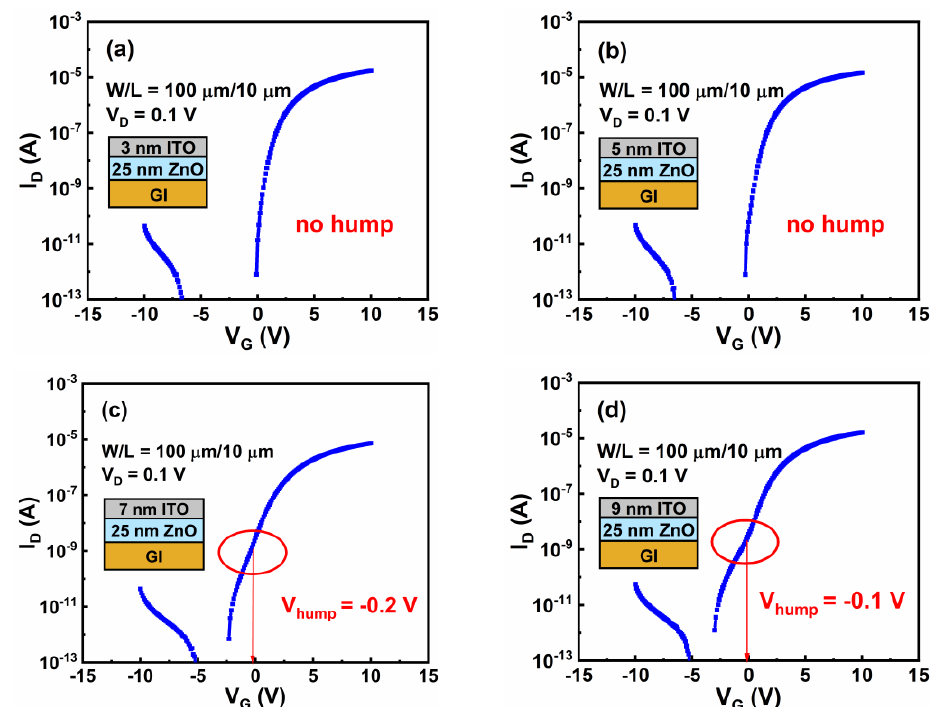
Figure 7. I D –V G curves for group B TFTs. The t ITO values are ( a ) 3 nm, ( b ) 5 nm, ( c ) 7 nm, and ( d ) 9 nm. The t ZnO value is 25 nm.